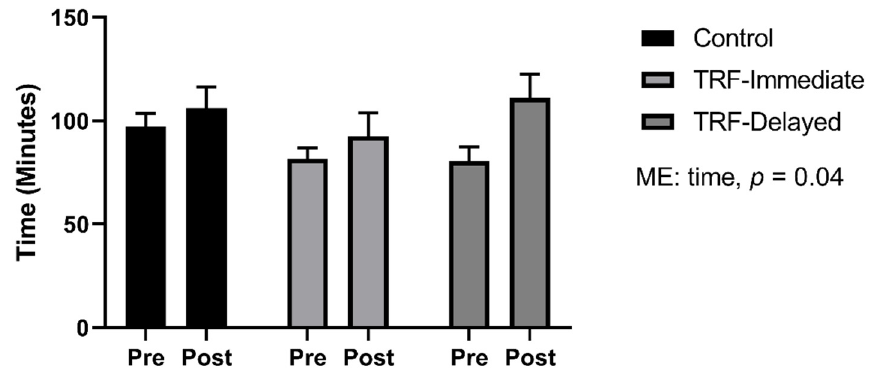
Figure 6. Run to exhaustion test was run both before and after 8 weeks of time-restricted feeding and exercise training. All data are presented as mean ± SEM. A repeated measures ANOVA was run to identify differences between groups and time.